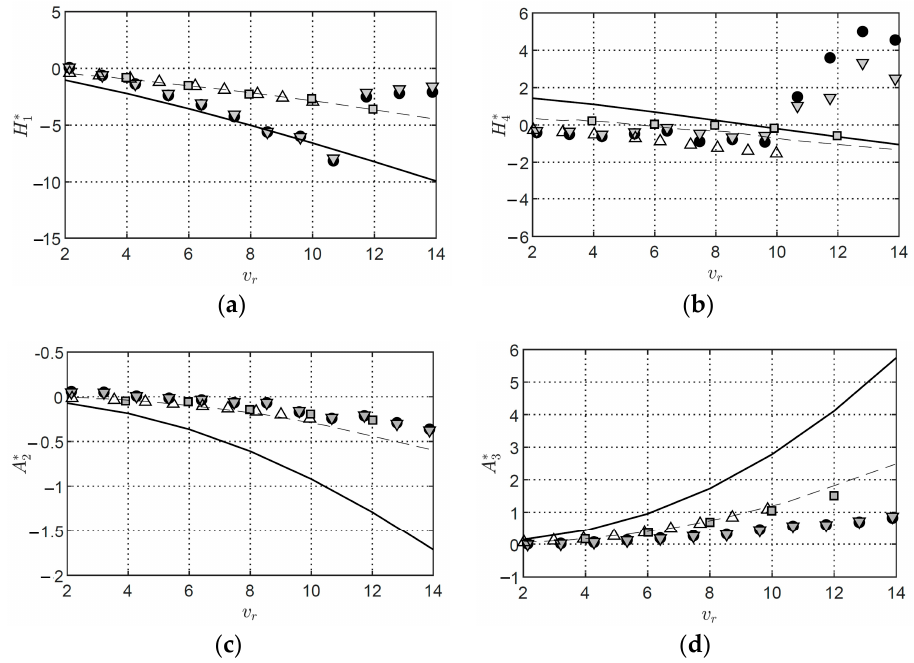
Figure 24. Aerodynamics derivatives of Great Belt Section: ( ● ) modi fi ed Ibrahim time domain method, ( (cid:72) ) iterative least square method, ( (cid:4) ) wind tunnel test (Larsen et al.) [42], ( ∆ ) wind tunnel test (Ge et al.) [2], ( ‒ ‒ ) water channel tests, ( ― ) fl at plate by Theodorsen. ( a ) 𝐻 (cid:2869)∗ ; ( b ) 𝐻 (cid:2872)∗ ; ( c ) 𝐴 (cid:2870)∗ ; ( d ) 𝐴 (cid:2871)∗ . Table 2. Experimental parameters for wind-off case from SDOF test .